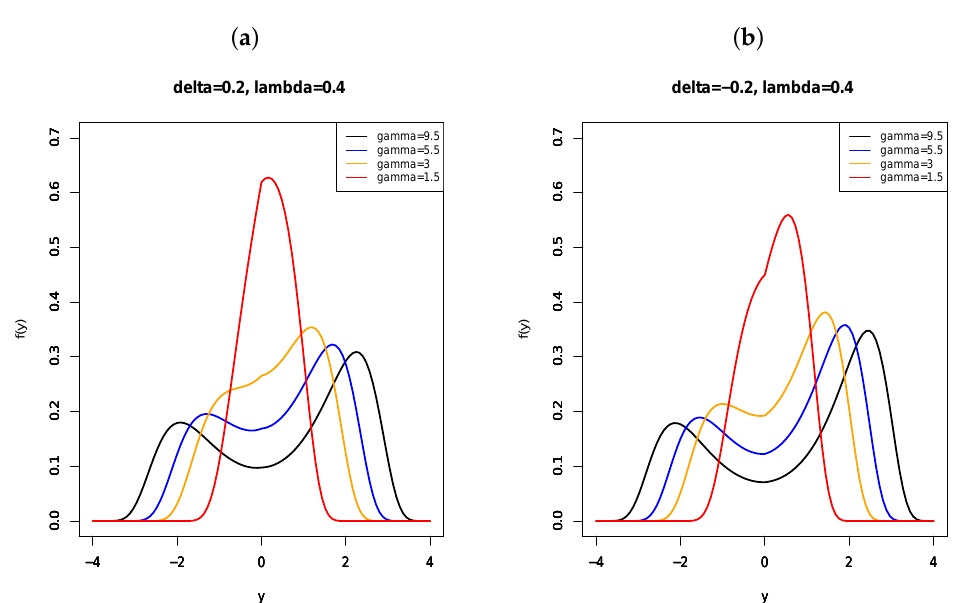
Figure 2. FSHN pdfs: ( a ) FSHN (9.5, 0, 1, 0.2,0.4) (black), FSHN (5.5, 0, 1, 0.2,0.4) (blue), FSHN (3, 0, 1, 0.2,0.4) (orange) and FSHN (1.5, 0, 1, 0.2,0.4) (red); and In ( b ) FSHN (9.5, 0, 1, − 0.2,0.4) (black), FSHN (5.5, 0, 1, − 0.2,0.4) (blue), FSHN (3, 0, 1, − 0.2,0.4) (orange) and FSHN (1.5, 0, 1, − 0.2,0.4) (red).